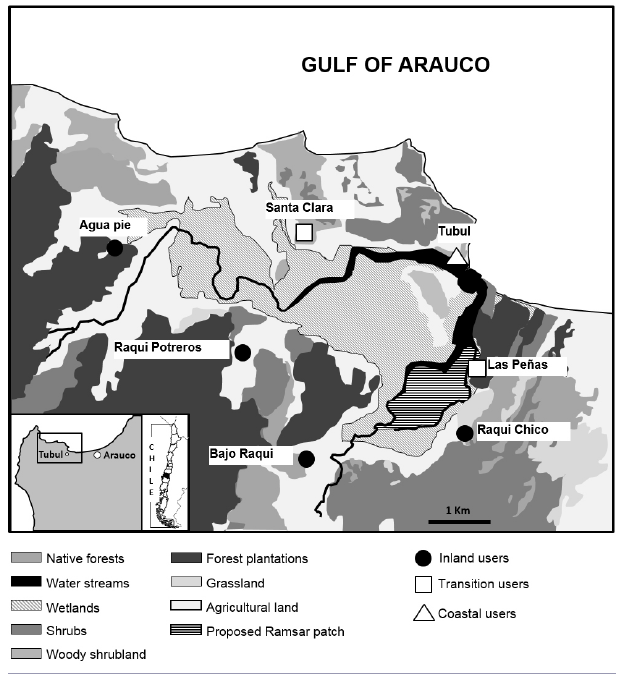
Fig. 2 . The Arauco Peninsula and the Tubul-Raqui wetland; grey-scale patches show land use before the 2010 earthquake (adapted from Centro de Ciencias Ambientales EULA 2008); shapes mark the studied locations and identify the three user groups defined for the analysis: triangle = coastal; squares = transition; circles = inland. Note that despite the relative closeness between Las Peñas and Raqui Chico, the former is in the wetland plain and the latter is on a surrounding hill. The black hatch wetland patch is the area proposed as a Ramsar site, in addition to the river